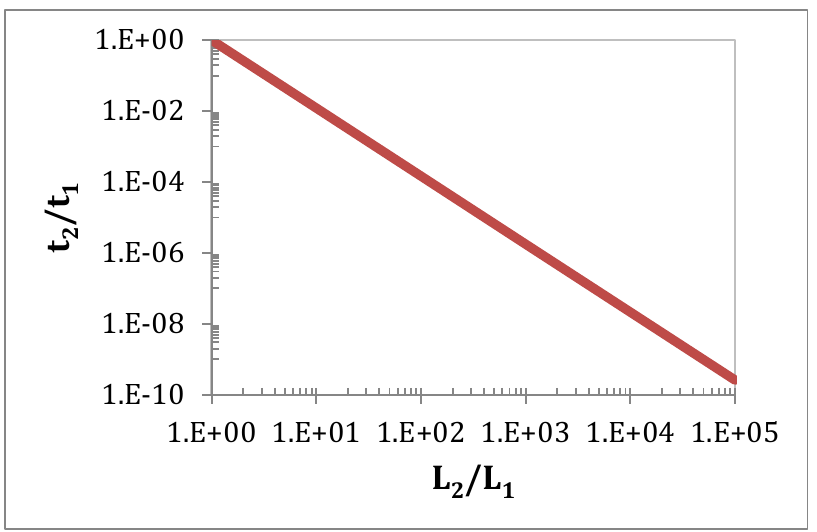
Figure 5. Size effects on E-glass filament rupture time in static fatigue under constant stress. Figure 5. Size e ff ects on E-glass filament rupture time in static fatigue under constant